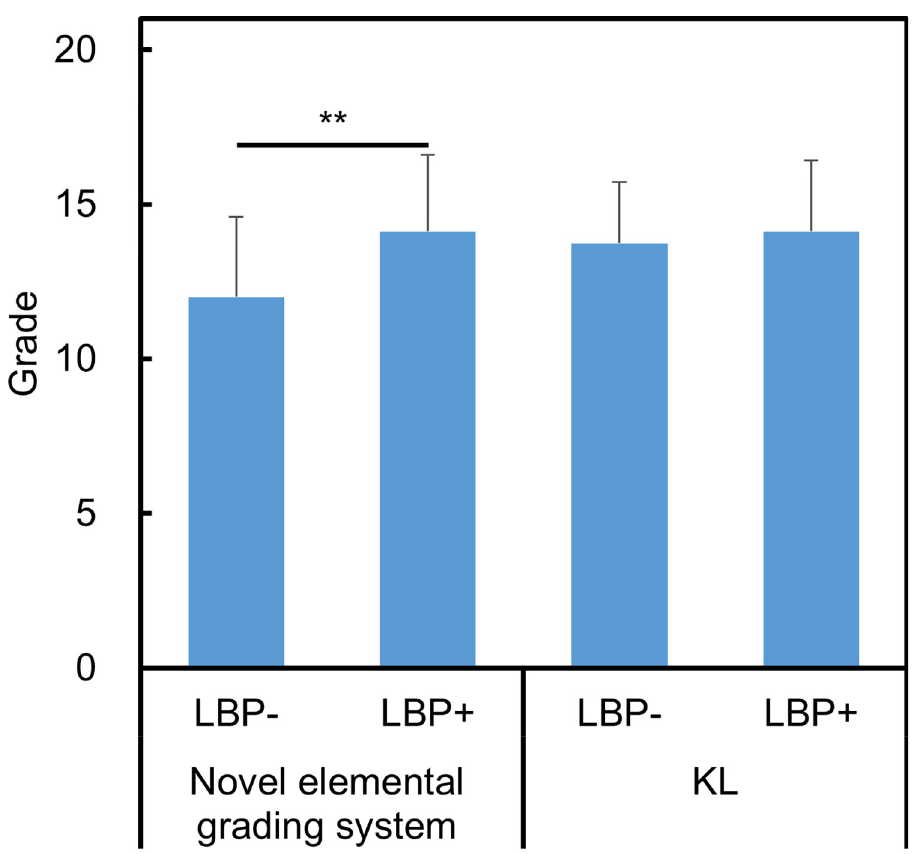
Fig 6. Intervertebral grade and Kellgren Lawrence grade of whole lumbar spine with or without low back pain. Mean intervertebral grade of whole spine (wIG) in the novel elemental grading system ( A ) and Kellgren Lawrence grade of whole spine (wKL) ( B ) with LBP (LBP+) or without LBP (LBP-) was shown. Data are expressed by mean ± standard deviation. Differences between the groups were statistically evaluated using Mann-Whitney test. � P < 0.05 and �� P < 0.01.